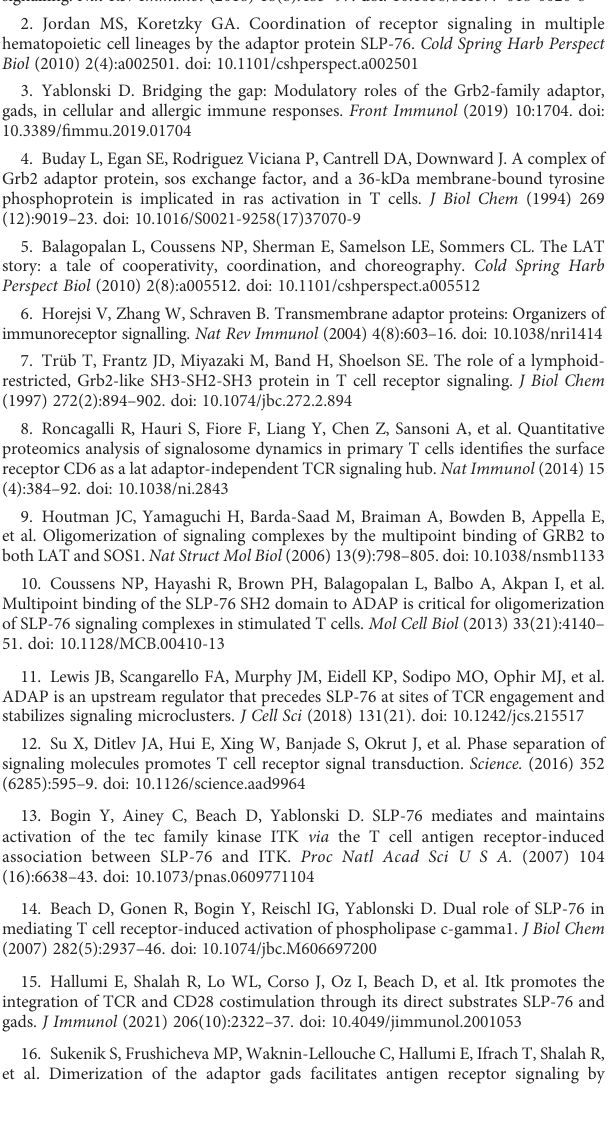
highlighted in red. Note that no speci fi c GRAP peptides were detected in none of these proteomes. SUPPLEMENTARY FIGURE 3 Dynamic of SLP76 OST interactions with GRB2-family adaptors. The abundances of GRB2-family adaptors and SLP76 were estimated for each time points and biological replicates (R1, R2 and R3). Normalized intensities (see Materials and Methods) from parental Jurkat (SLP76) and SLP76 OST cells were compared using a two-sided Welch t-test (symbols used according to the t-test P-value: N.S., P > 0.05; *P ≤ 0.05; **P ≤ 0.01; ***P ≤ 0.001). Imputed missing values are represented with lighter shaded dots. SUPPLEMENTARY TABLE 1 List of the proteome of variant Jurkat cells expressed in copy numbers. SUPPLEMENTARY TABLE 2 List of the SLP76 – prey interactions identi fi ed in the present study. each line shows an interaction between SLP76 and a prey and includes the corresponding enrichments and stoichiometries before stimulation and at each stimulation time